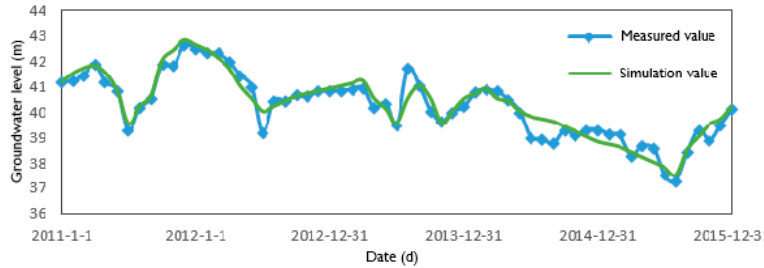
Figure 8. The groundwater level dynamic curve-fitting process.